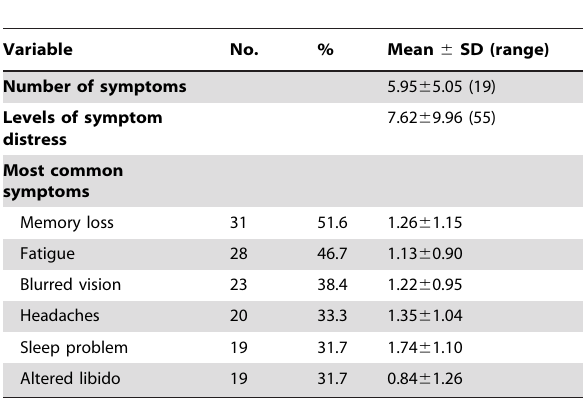
Table 1. Distribution of symptom distress after Stereotactic Radiosurgery in patients with pituitary tumors ( n =60).